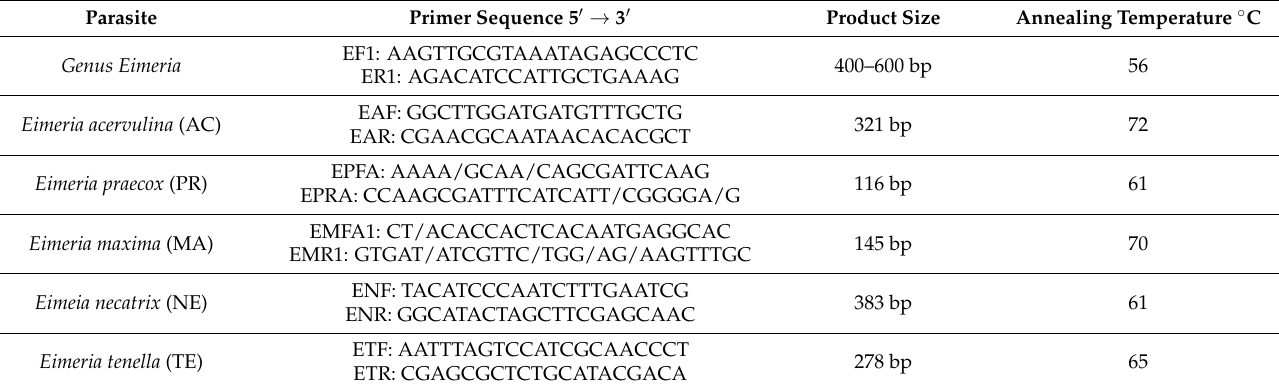
Table 1. Genus-specific and species-specific primers of Eimeria.